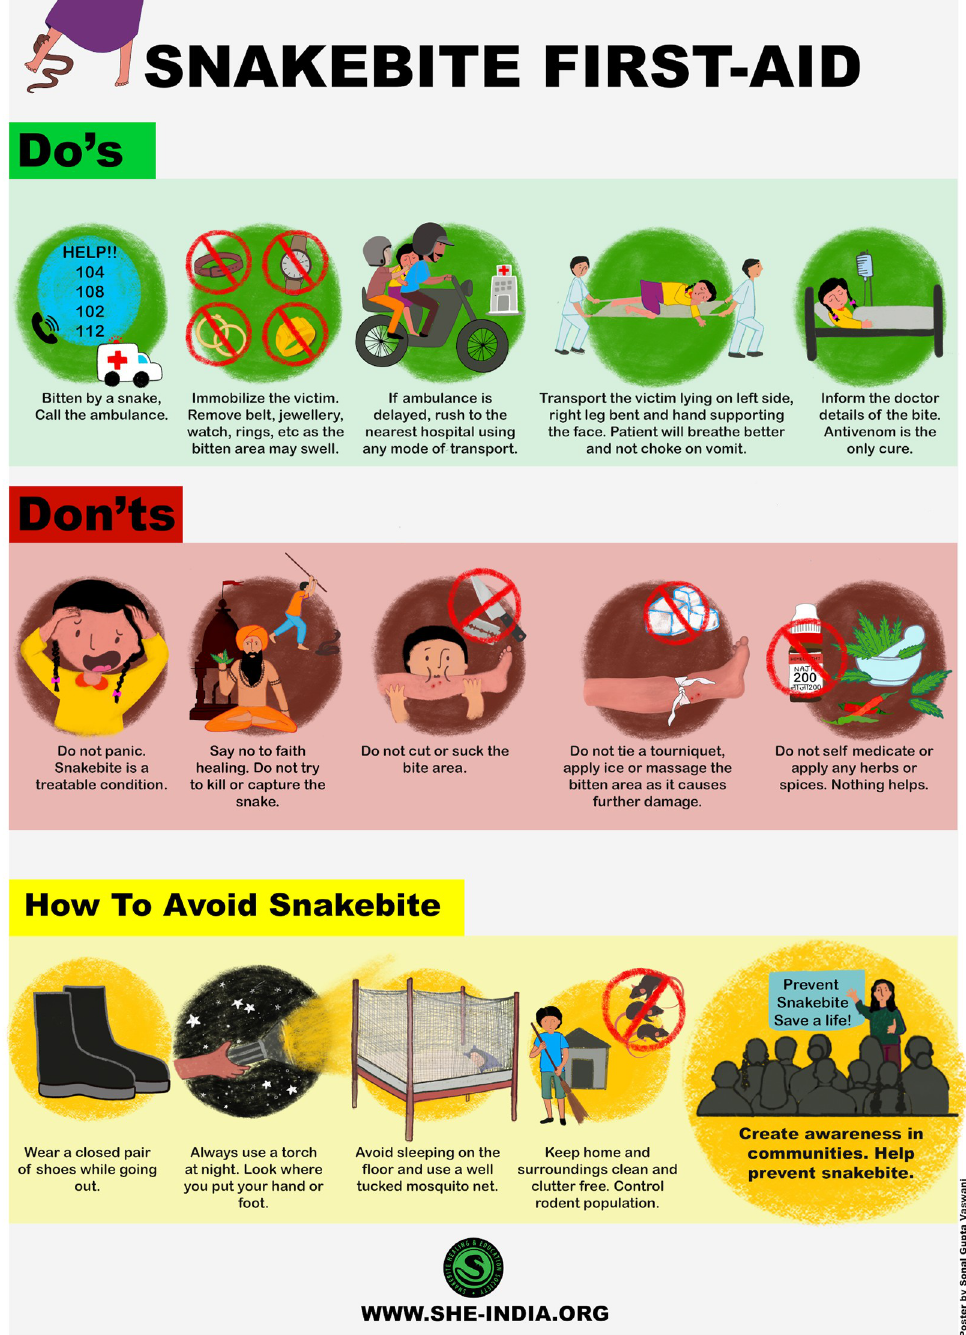
Fig 2. Example of clear, illustrative poster on snakebite awareness. This poster is available in 6 regional languages of India and aims to translate into further 11